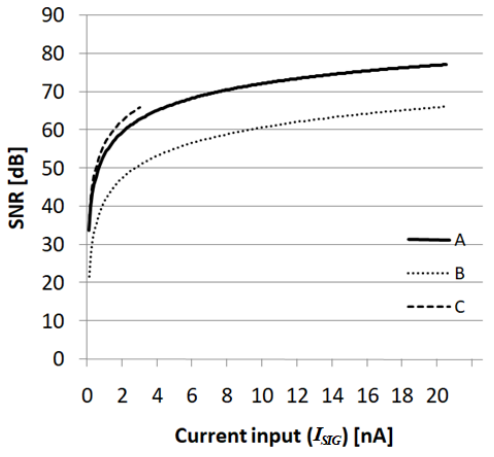
Figure 9. Histograms of the digital output of the proposed ADC with a fixed input: ( a ) where the number of MSBs counting is 1; ( b ) where the number of MSBs counting is 63.